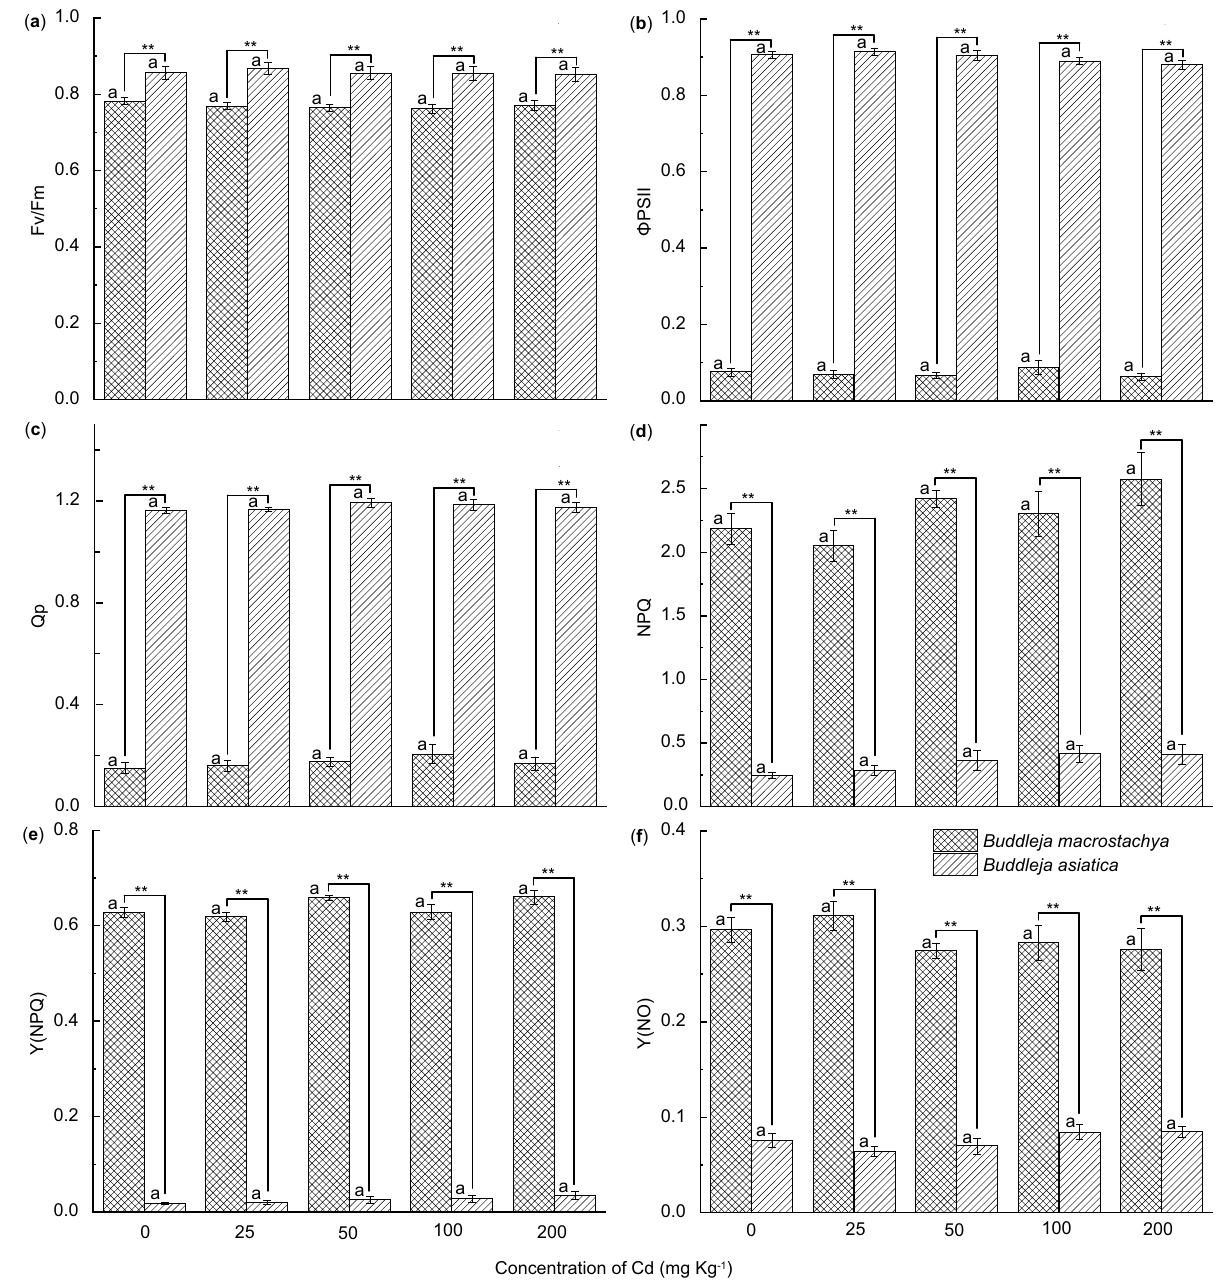
Figure 1. The effects of Cd treatments on ( a ) Fv/Fm, ( b ) ΦPSII, ( c ) Qp, ( d ) NPQ, ( e ) Y(NPQ), and ( f ) Y(NO) in the leaves of B. asiatica and B. macrostachya . Values are represented as the mean ± S.E. (n = 5). Asterisks indicate significant differences between different species at the same Cd level according to LSD-tests (**, p < 0.01). ( a – f ) were separately created by using ORIGIN (Version 2019b, OriginLab Corporation, USA) and then adjusted and assembled using Adobe Illustrator CS4 software (Adobe Systems, San Jose, CA). (Fv/Fm): the quantum yield of PSII, ΦPSII: the effective quantum yield of PSII, Qp: photochemical quenching, NPQ: non- photochemical quenching, Y(NPQ): the quantum of regulated energy dissipation, Y(NO): the quantum yield of non-regulated energy